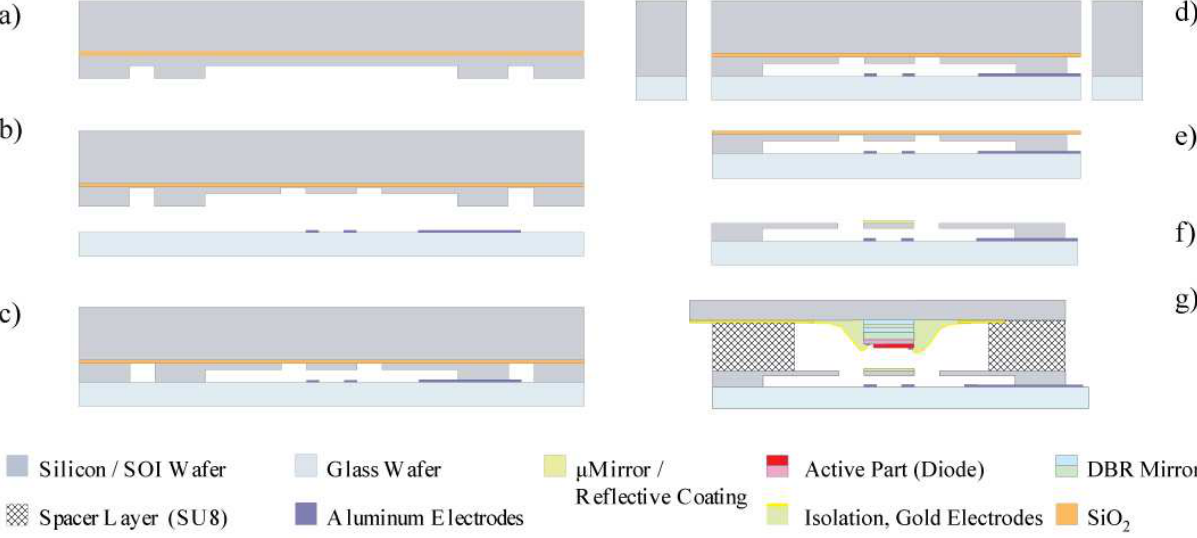
Figure 3: Tunable RCED fabrication process: two successive silicon DRIE steps to form a) the electrostatic actuation gap and b) the mirror and suspension. Glass wafer preparation with counter electrodes and c) anodic bonding, followed by d) dicing and e) handle layer and buried oxide removal. f) Reflective coating deposition and g) integration with the detector part, resulting in the complete tunable RCED device as shown in Figure